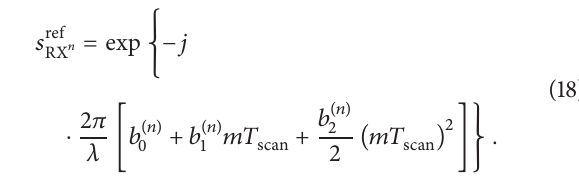
Figure 3: Array parameters as a function of the target parameters = 3 ( 𝑇 scan